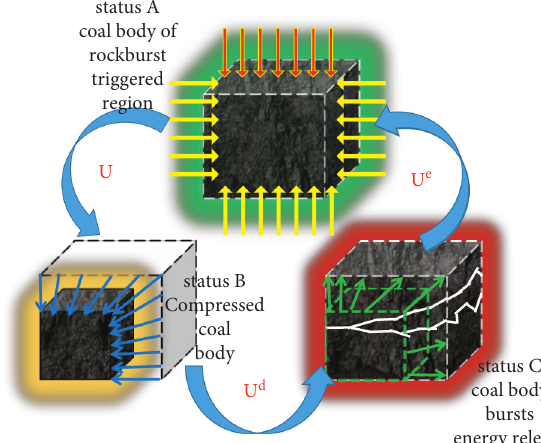
Figure 1: Energy transfer form of elastic strain between microcoal and rock